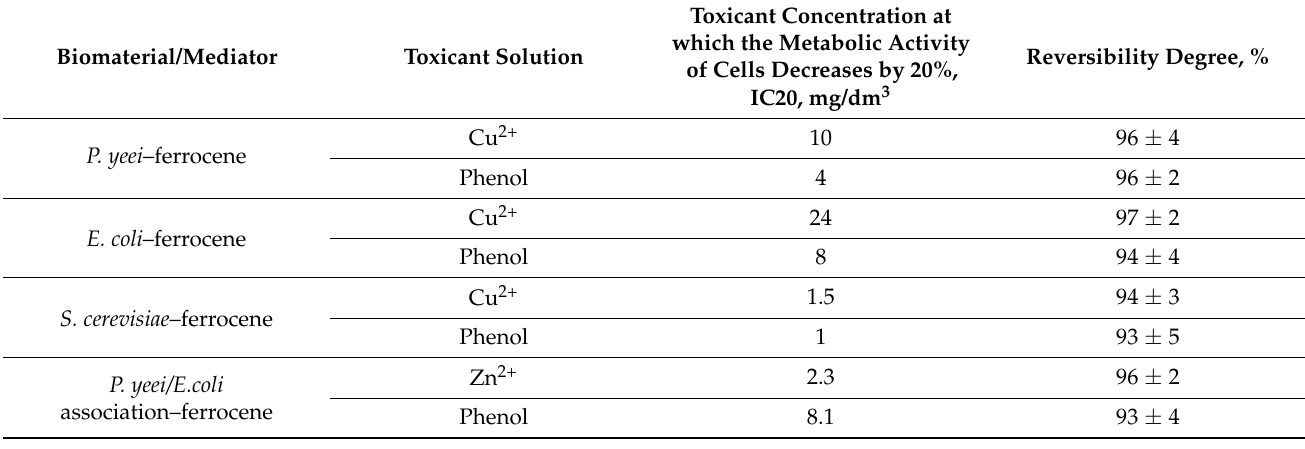
Table 4. Concentrations of toxicant solutions at which the metabolic activity of the bioreceptor element decreases by